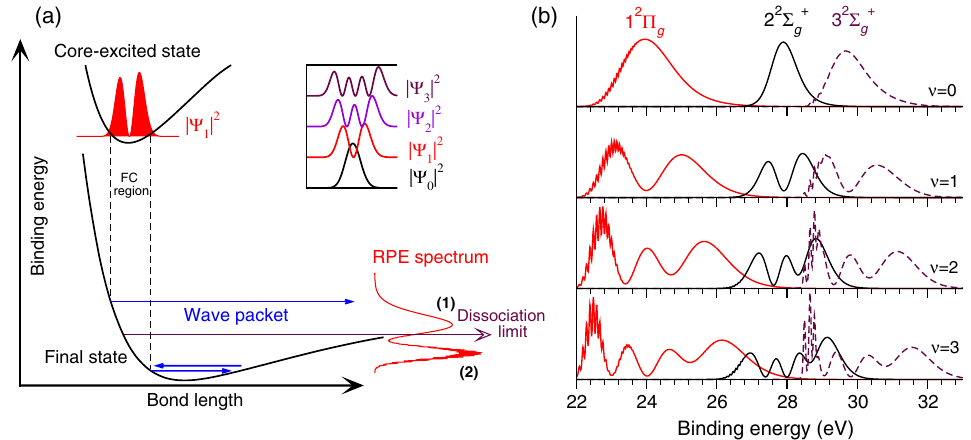
FIG. 11. (a) Geometric interpretation of the phenomenon of mapping of the core-excited vibrational wave functions onto a bound state as an example. The squared moduli of the core-excited final state based on the reflection principle (see the text), using the 1 2 (cid:2) g vibrational wave functions ( (cid:3) ¼ 0 ; . . . ; 3 ) are shown in the inset. The FC region is marked by the vertical dashed lines. (b) Theoretical , 2 2 (cid:1) þ , and 3 2 (cid:1) þ final bound states resulting from excitation of the (cid:3) ¼ 0 ; . . . ; 3 core-excited vibrational RPE spectra of the 1 2 (cid:2) g g g wave functions. The spectral profile reflects the nodal structure of the corresponding vibrational wave function [see the inset in